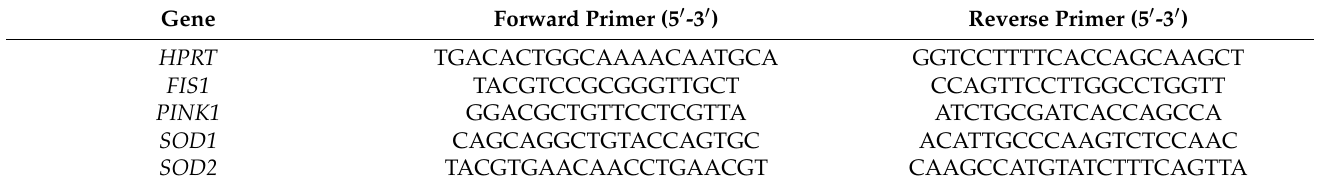
Table 3. Forward and reverse primers used for analysis of gene